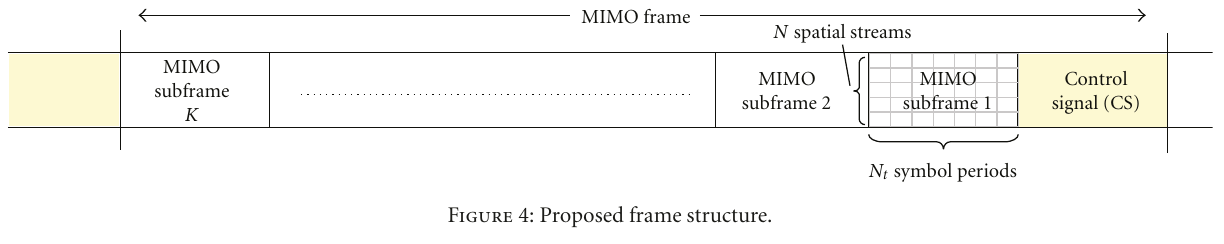
Figure 4: Proposed frame